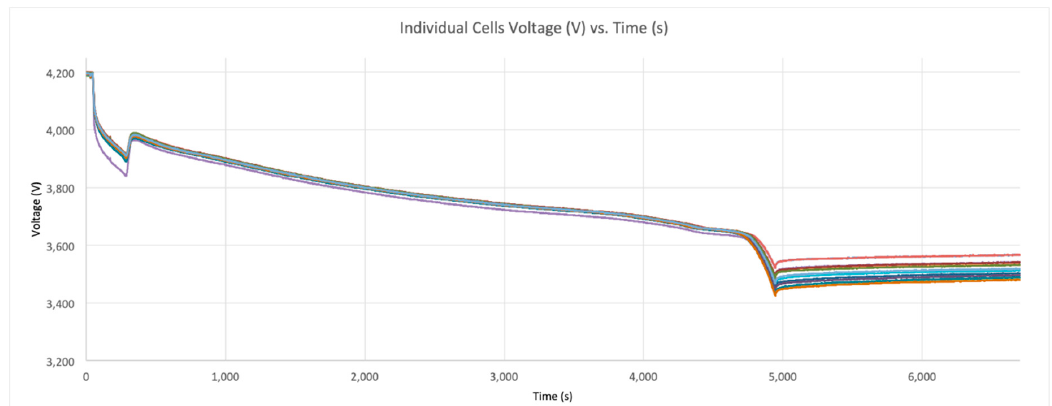
Figure 21. Battery pack test. Individual cells voltage behavior under flight load profile.